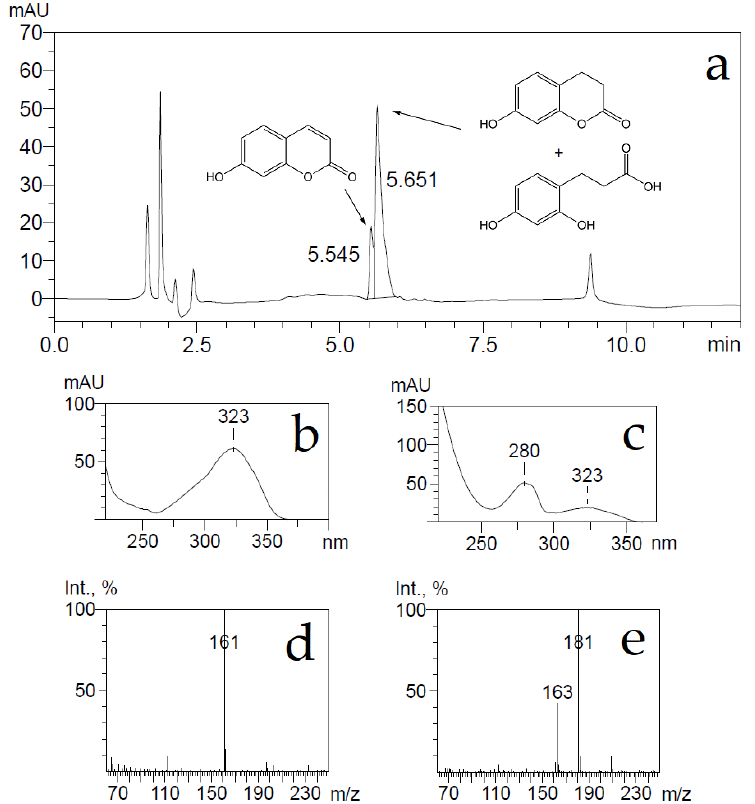
Figure 6. Bioconversion of 7-hydroxycoumarin by E. coli BL21 bacteria containing the induced hcdE gene. Produced metabolites were analyzed by HPLC-MS. UV 280 nm trace of metabolites ( a ). UV and MS spectra of peaks with retention times 5.545 min ( b , d ) and 5.651 min ( c , e ). The negative ions [M-H] − generated were at m / z 181 (3-(2,4-dihydroxyphenyl)propionic acid), 161 (7-hydroxycoumarin) and 163 (7-hydroxy-3,4-dihydrocoumarin).